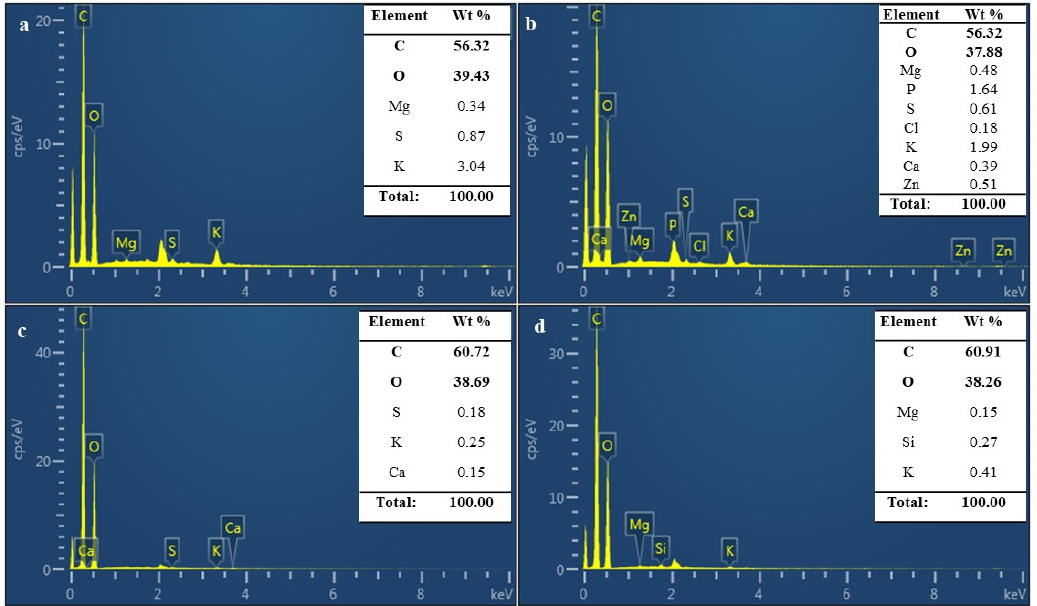
Figure 6. EDX analysis of MBLs. ( a ) control, ( b ) control hotpress, ( c ) 20%-PEG-control, and ( d ) 20%- PEG-hotpress samples.